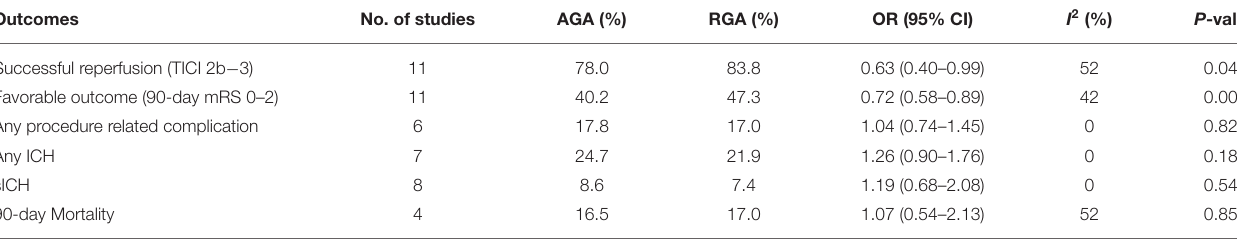
TABLE 3 | Pooled meta-analysis outcomes of antegrade and retrograde approaches. Outcomes